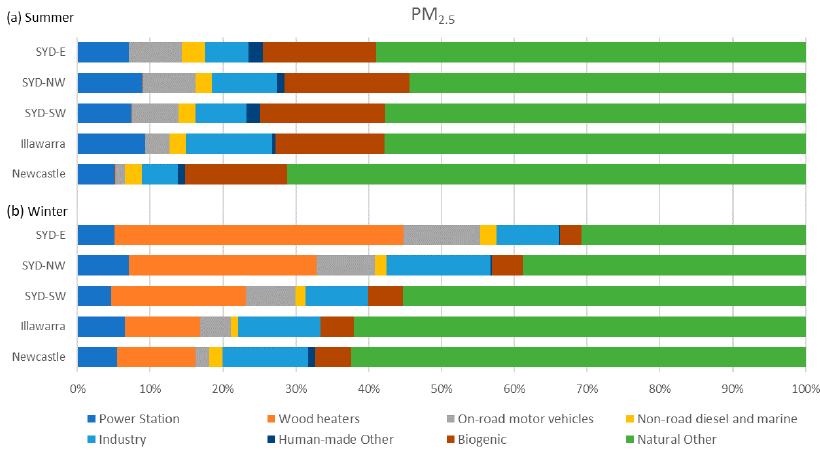
Figure 6. Regional average major source groups contribution (%) to total PM2.5 mass in the Sydney East (SYD-E), Sydney Northwest (SYD-NW), Sydney Southwest (SYD-SW), Illawarra and Newcastle regions in ( a ) summer and ( b ) winter of 2008.